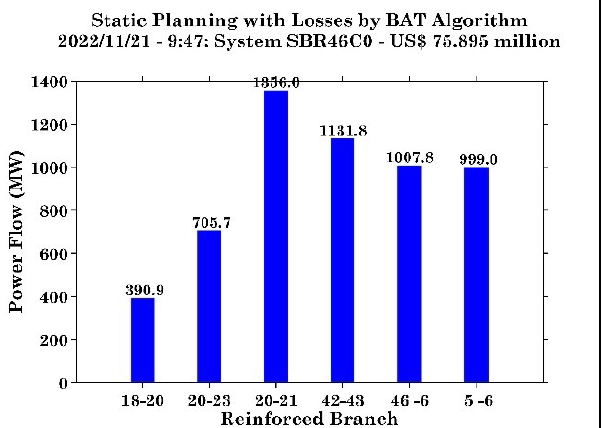
Figure 16: Case WR - SB-46/79 test system. Flows in the branches. Source: BATp optimizer, (2022).